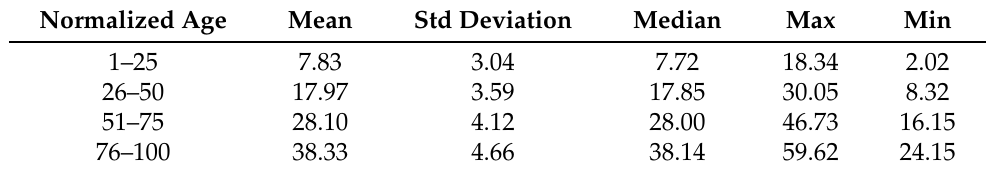
Figure 3. Box-plot of the report footprint (from mobile app to cloud module ) with respect to the aggregated normalized age. Median values are red lines, mean values are blue stars, and outliers are black dots. Table 2. Report footprint (expressed in KB) statistics with respect to normalized age (pure number).